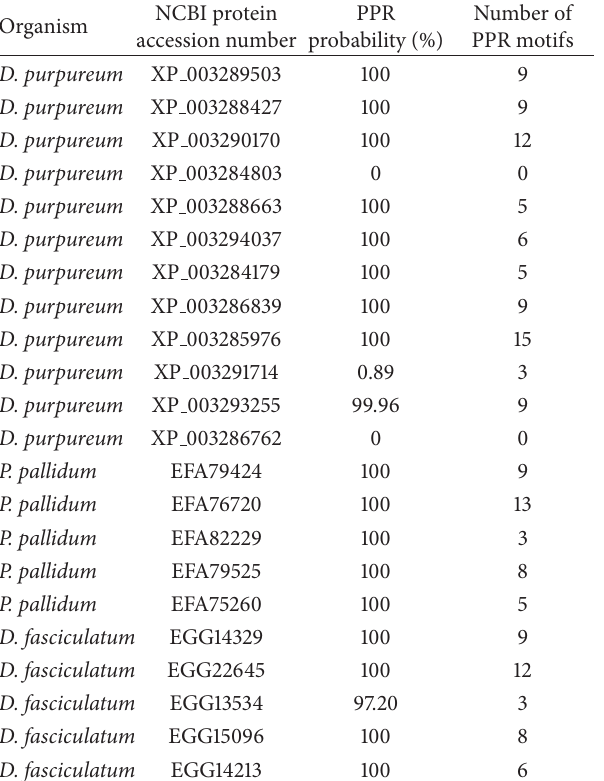
Table 3: Bioinformatic analysis of D. discoideum PPR protein homologs in other cellular slime moulds. The probability of helical repeats being PPR and the predicted number of motifs were determined using TPRpred.